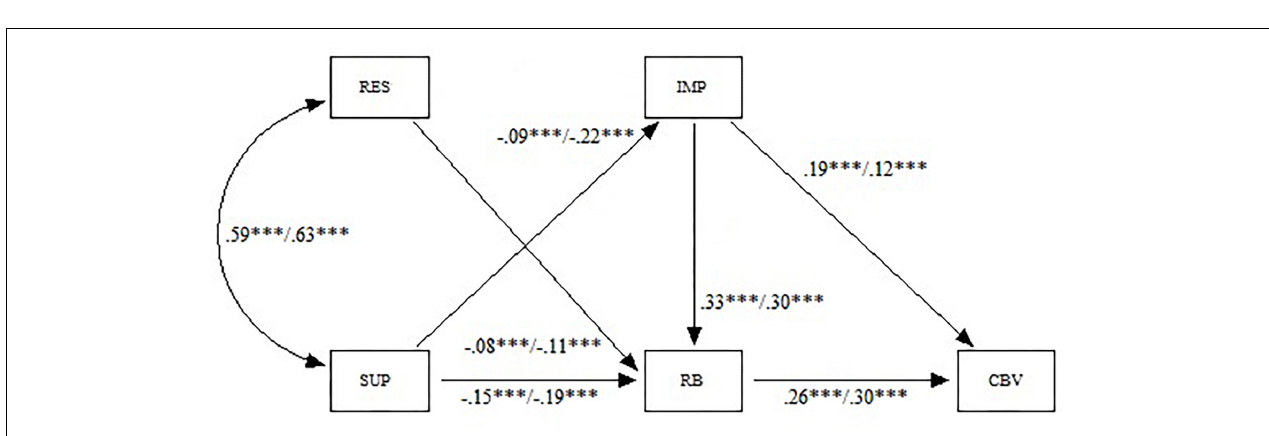
FIGURE 3 | Result of the path analysis performed with boys (left) and girls (right) (RES, restriction; SUP, supervision; IMP, impulsivity; RB, risk behaviors; CBV, cyber-victimization). ∗∗∗ p ≤ 0.001.